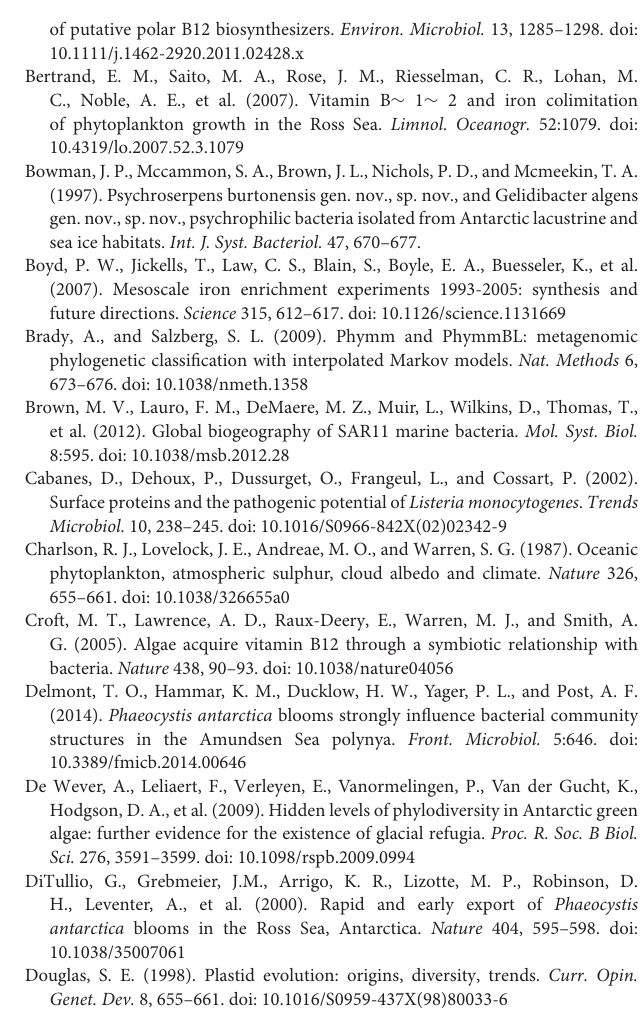
Figure S4 | Hierarchical clustering (Euclidean distance metric) of 1000 scaffolds ( > 6.7kb in length) based on their tetranucleotide frequency profiles. Scaffolds were assembled using 20 million gapped reads to optimize the recovery of the dominant and sub-dominant genetic structures. Four informative layers were added below to the clustering tree. Taxonomical affiliation was inferred using phymmBL (Brady and Salzberg, 2009). Figure S5 | Hierarchical clustering (Euclidean distance metric) of 1000 scaffolds ( > 10.1kb in length) based on their tetranucleotide frequency profiles. Scaffolds were assembled using 40 million gapped reads to optimize the recovery of the dominant and sub-dominant genetic structures. Four informative layers were added below to the clustering tree. Taxonomical affiliation was inferred using phymmBL (Brady and Salzberg, 2009). Figure S6 | Hierarchical clustering (Euclidean distance metric) of 3553 scaffolds ( > 6kb in length) based on their tetranucleotide frequency profiles. Scaffolds were assembled using the entire metagenomic dataset to optimize the recovery of the less abundant genetic structures. Five informative layers were added below to the clustering tree. Taxonomical affiliation was inferred using phymmBL (Brady and Salzberg, 2009). A cluster of 1071 scaffolds affiliated to Micromonas and representing a total of 19.6Mb was recovered from this analysis. Figure S7 | Length of scaffolds associated to the Micromonas ASP10-1a draft genome. A scaffold length logarithmic regression curve was